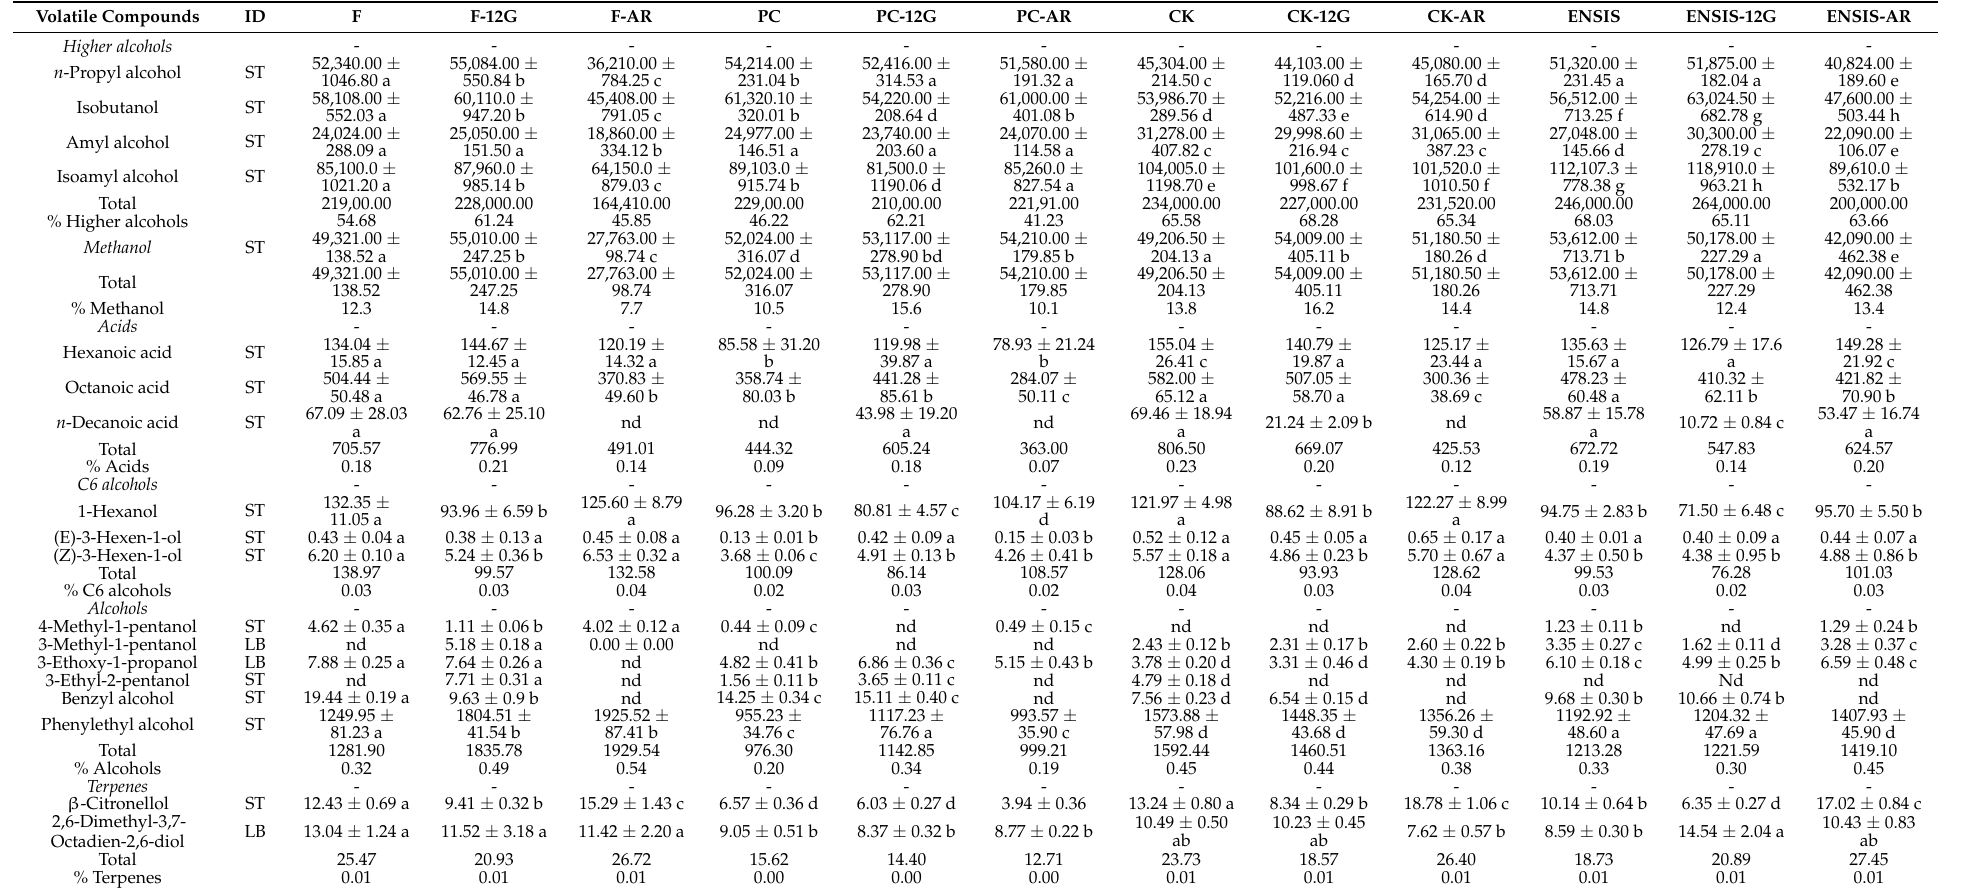
Table 2. Volatile compound concentrations ( µ g/L) of Palomino fino wines made using aroma-release